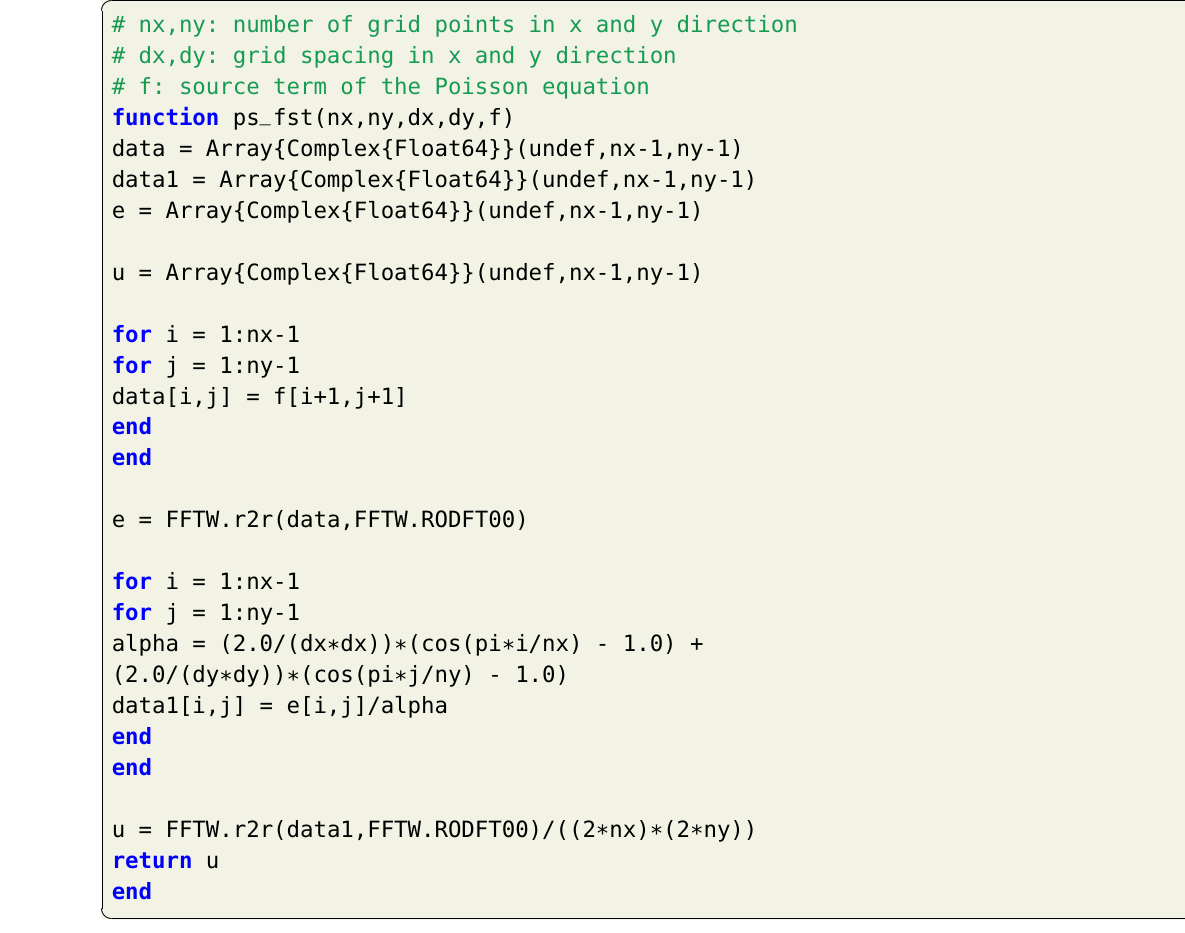
and numerical solution for the test problem computed using sine transform. Listing 20. Implementation of Julia function for the Poisson solver using fast sine transform (FST) for the domain with Dirichlet boundary condition.